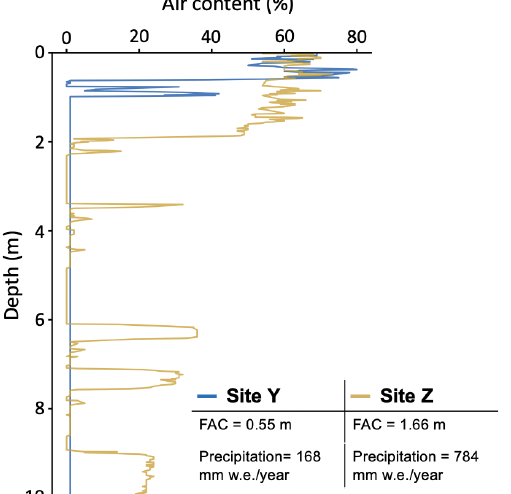
Figure B6. Simulated air content profiles at sites Y and Z. Firn air content (FAC) in the top 10m and total annual precipitation from the RACMO 1958–2017 climatology for each site are noted in the